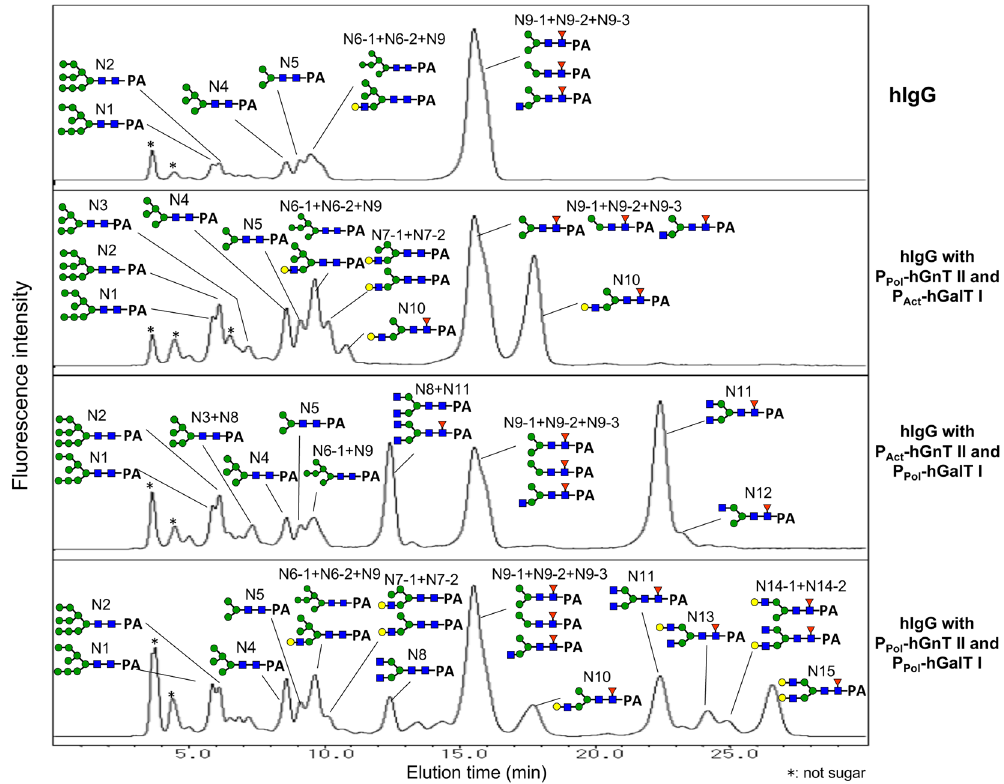
Figure 6. Chromatograms of PA-derivatized N -glycans derived from recombinant IgG from silkworm coexpressed with hGnT II and hGalT I, as determined via ODS column chromatography. N1 to N15 correspond to the number of N -glycans, as shown in Fig.